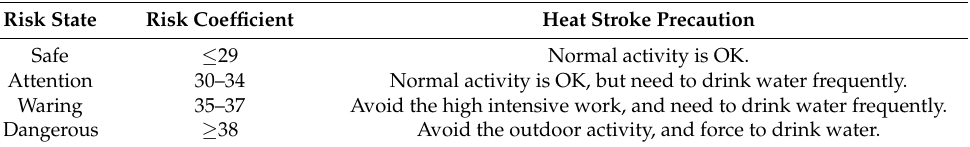
Table 2. Heat stroke risk coefficient.